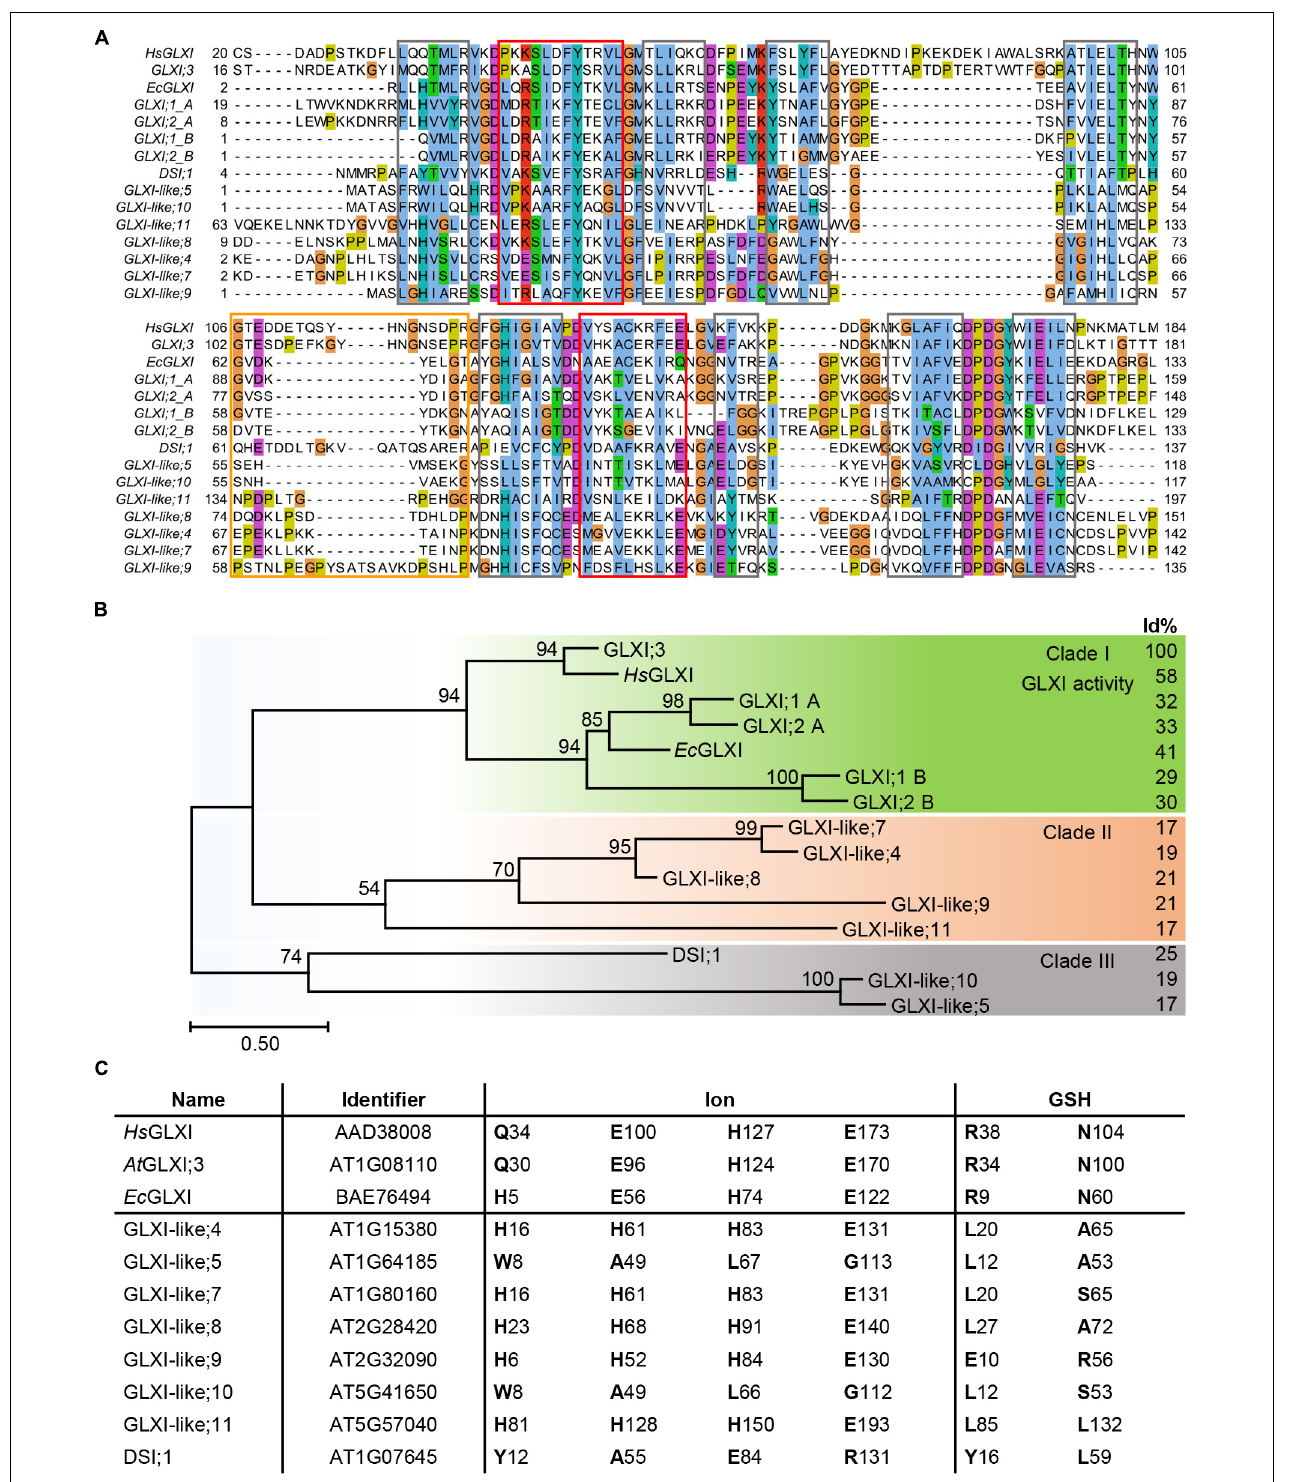
FIGURE 1 | Molecular phylogenetic analysis of Arabidopsis GLXI and GLXI-like proteins. (A) Aligned amino acid sequences of GLXI- and GLXI-like proteins. PROMASL3D alignment was constructed with default settings and displayed with Jalview (Pei et al., 2008b; Waterhouse et al., 2009); non-conserved N and C-terminal parts are partially masked. highlighted: gray = β -sheet, red = α -helix, and orange = hinge region. (B) Molecular phylogenetic analysis. The evolutionary history was inferred by using the Maximum Likelihood method based on the best fitting Le_Gascuel_2008 model (Le and Gascuel, 2008). The percentage of trees in